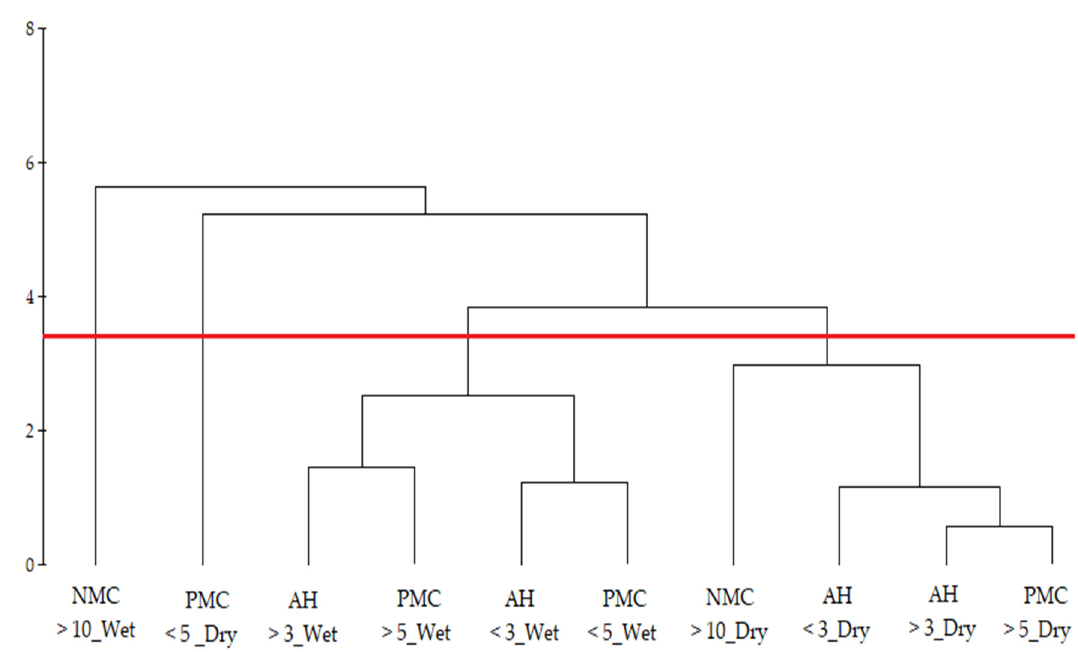
Figure 2. Water quality classification at the locations on shallow acid sulfate soils.